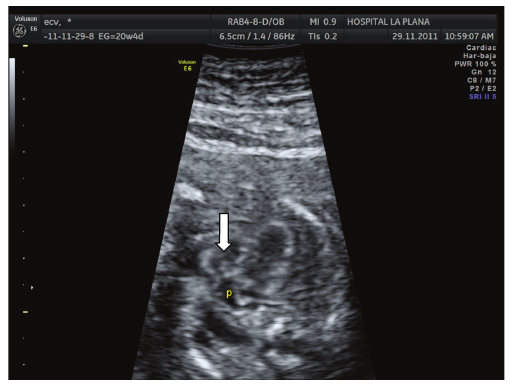
Figure 2: Small stenotic pulmonary vein (p) is seen connecting with the right ventricle (arrow).